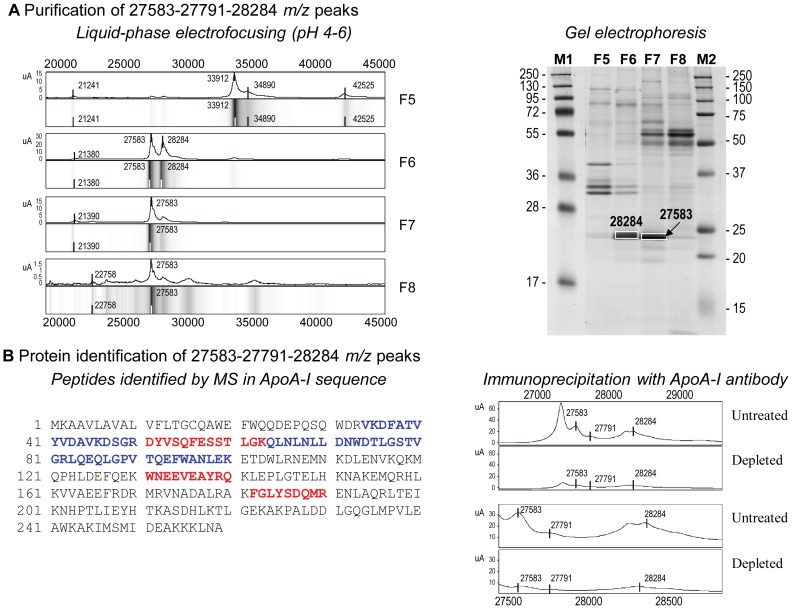
Purification and identification of the proteins corresponding to the 27583, 27791, and 28284 m/z peaks.(A) SELDI-TOF-MS protein spectrum of fractions F5, F6, F7, and F8 from MicroRotofor® cell, by a pH gradient 4–6 (left panel). Each fraction (F5, F6, F7, and F8) was analyzed on NU-PAGE 10% coomassie blue stained-gel. The bands corresponding to the 27583, 27791, and 28284 m/z peaks were framed (right panel). (B) Peptides identified by mass spectrometry corresponding to apolipoprotein A-I. Aminoacids indicated in red corresponds to peaks 27583 and 27791, and those indicated in blue correspond to peak 28284 m/z (left panel). SELDI-TOF-MS protein spectra of crude (untreated) and immunodepleted plasma with ApoA-I antibody (depleted) showed the decrease in 27583, 27791, and 28284 m/z peaks following immunodepletion, validating the identification (right panel).